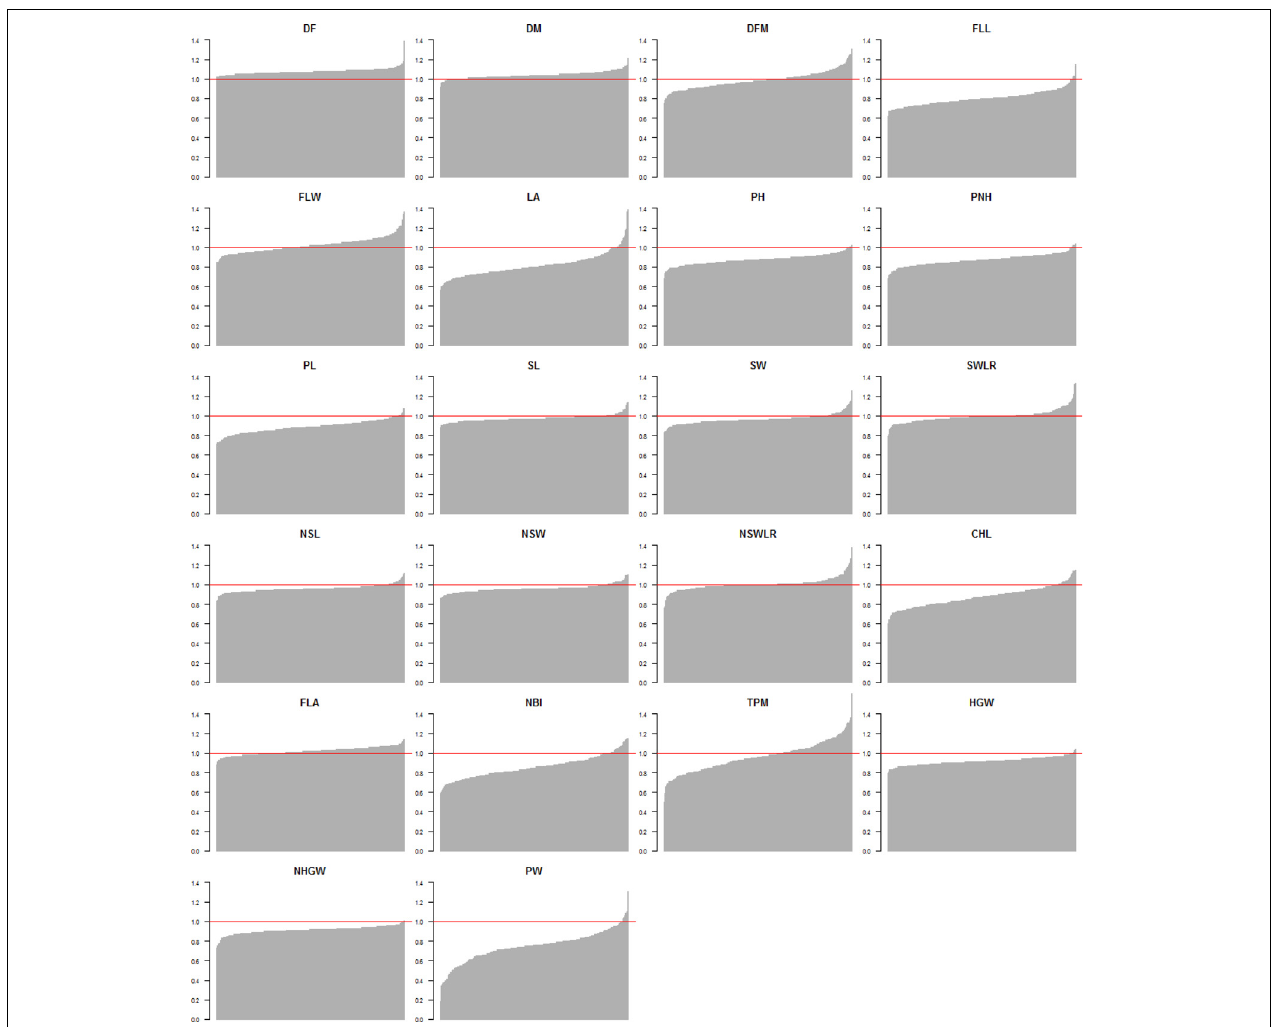
FIGURE 2 | Distribution of the phenotypic value ratio (LW/PF) for all traits used for the genome-wide association study. The red horizontal line represents the 1 value (i.e., accessions showing the same value in both